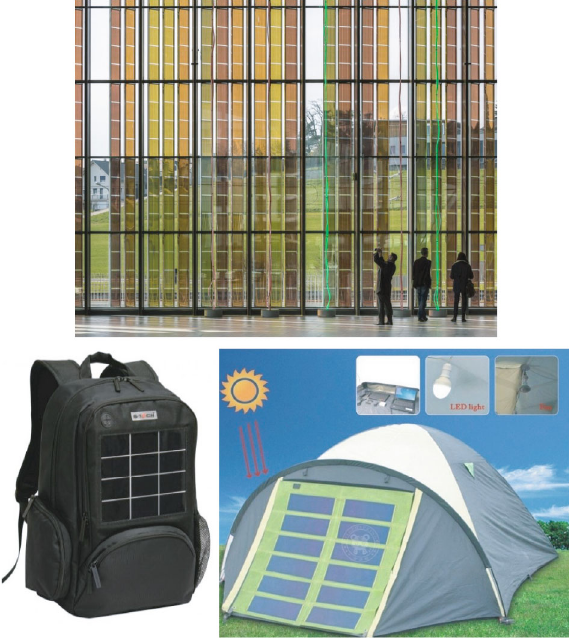
Figure 6: Examples of applications for dye-sensitized solar cells and modules